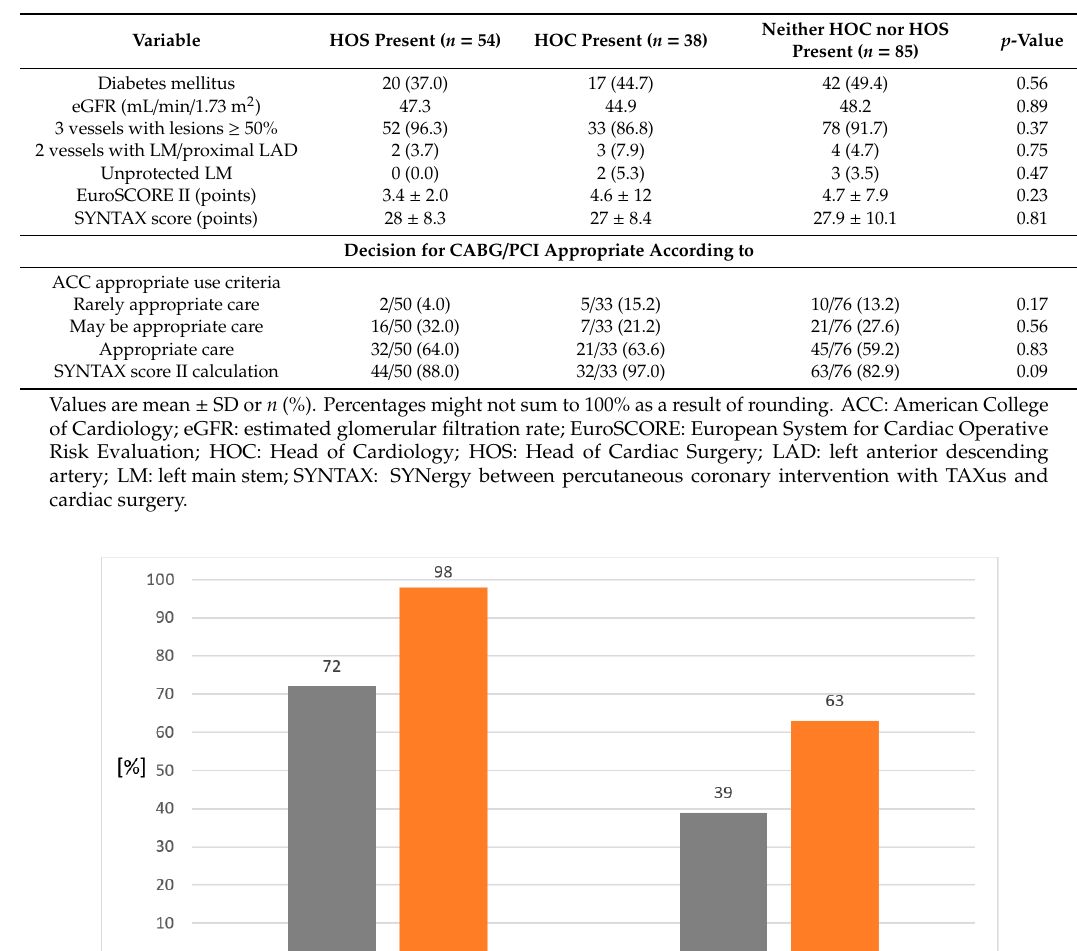
Table 2. Angiographic characteristics and appropriateness calculations.